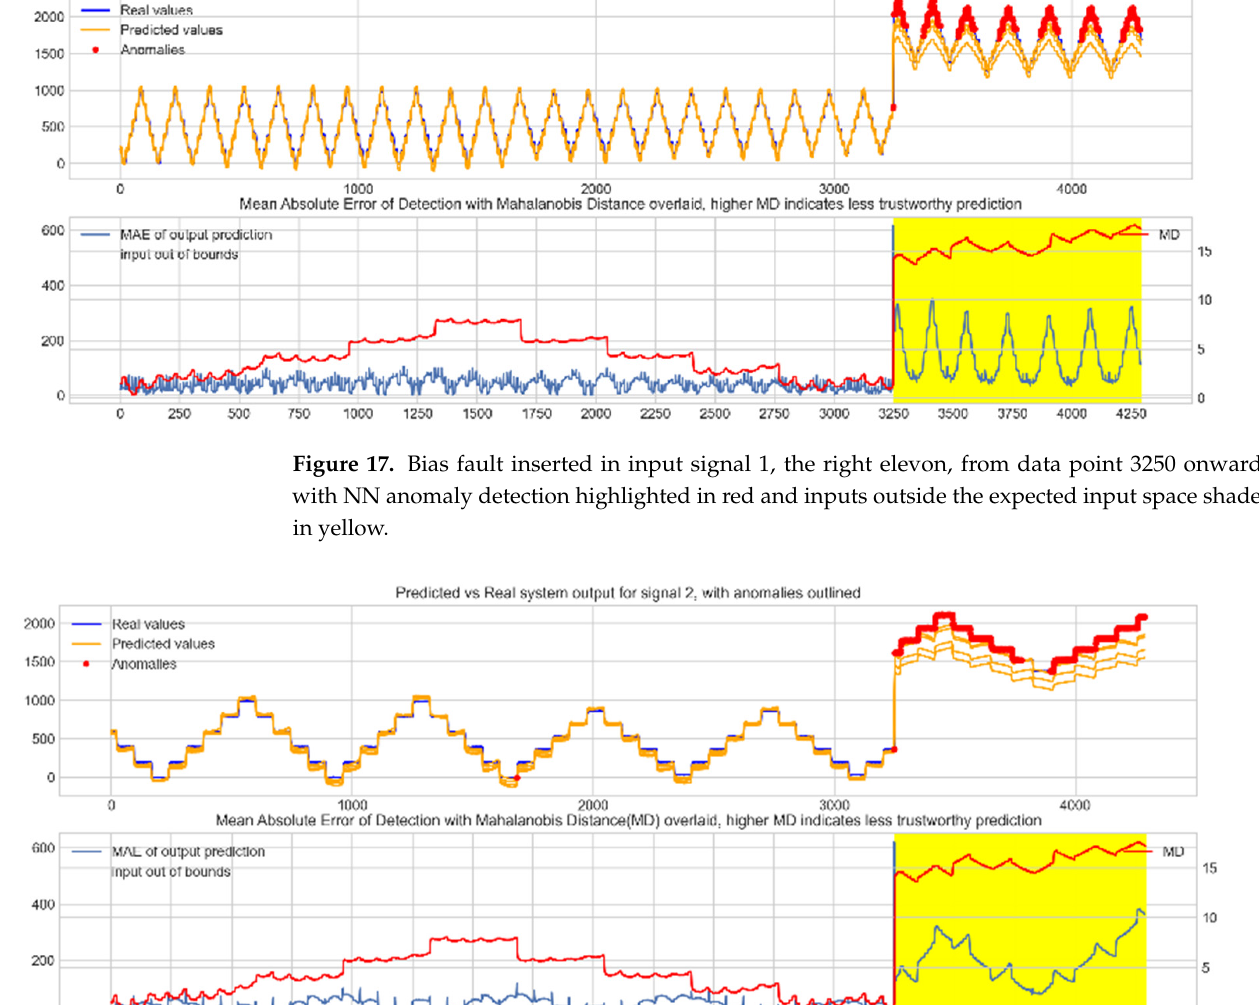
Figure 18. Bias fault inserted in input signal 2, the left elevon, from data point 3250 onwards, with NN anomaly detection highlighted in red and inputs outside the expected input space shaded in yellow.